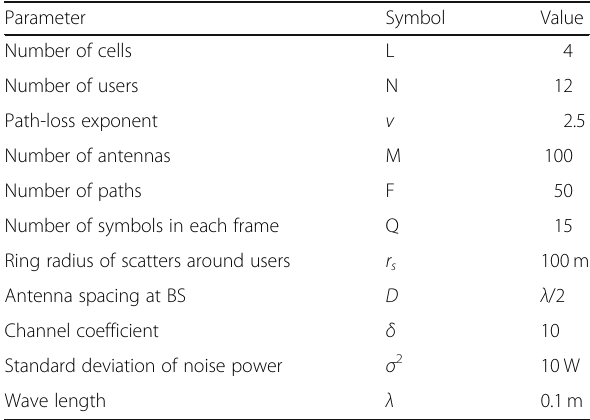
Table 1 Simulation